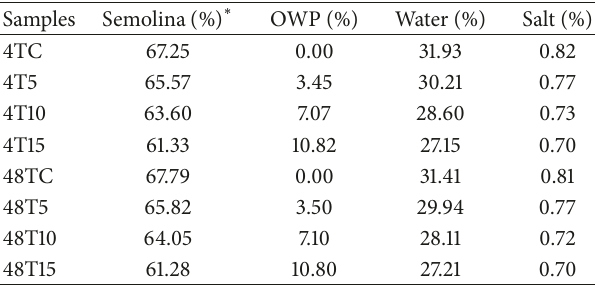
Table 1: Formulation of doughs prepared with low grade semolina (4T and 48T) and different percentages of